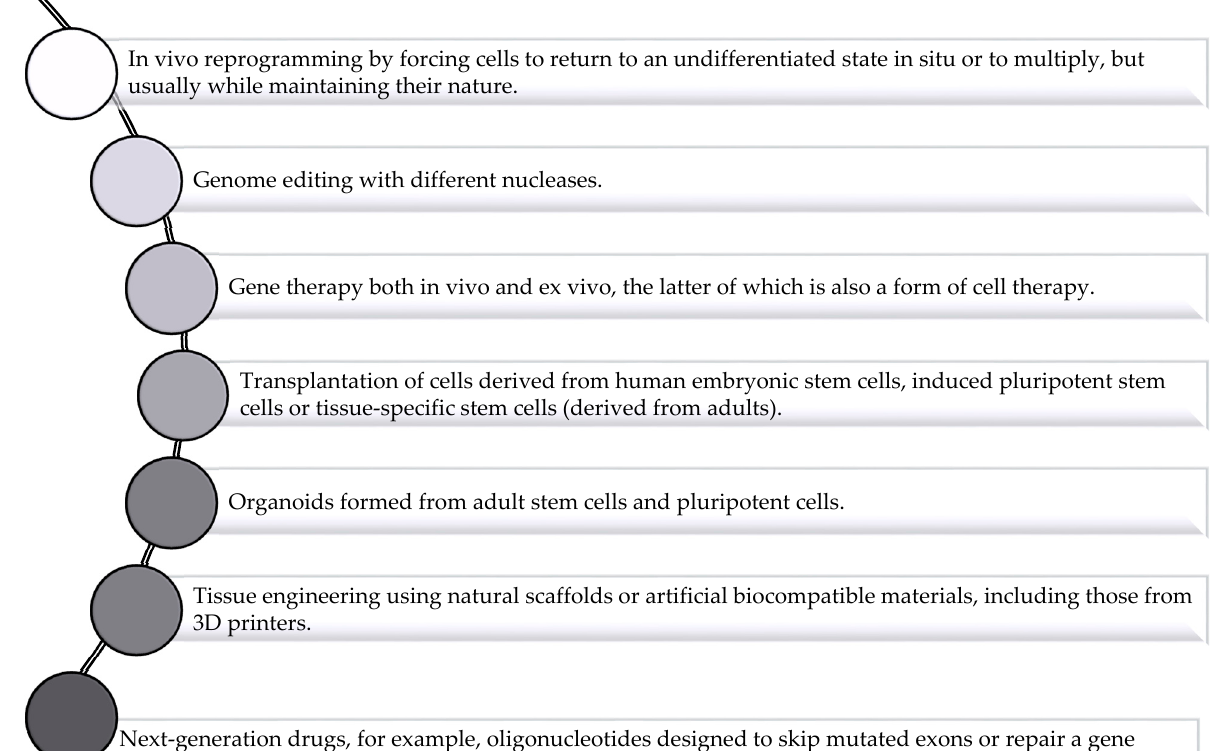
Figure 1. Regenerative medicine: different types of therapy (based on